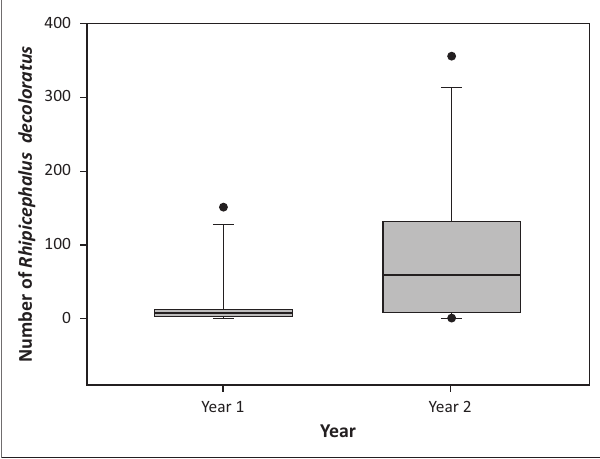
FIGURE 8: Boxplot depicting annual increase of Rhipicephalus decoloratus larvae collected from the vegetation in the grassland in the sable antelope breeding enclosures from the first year (July 2011–July 2012) to the second year (July 2012–July 2013) on the farm Hoopdal KQ96. The middle bar, the box and the whiskers refer to the median, the interquartile range and the interoctile (80 % ) range, whilst the dots are extremes or outliers.